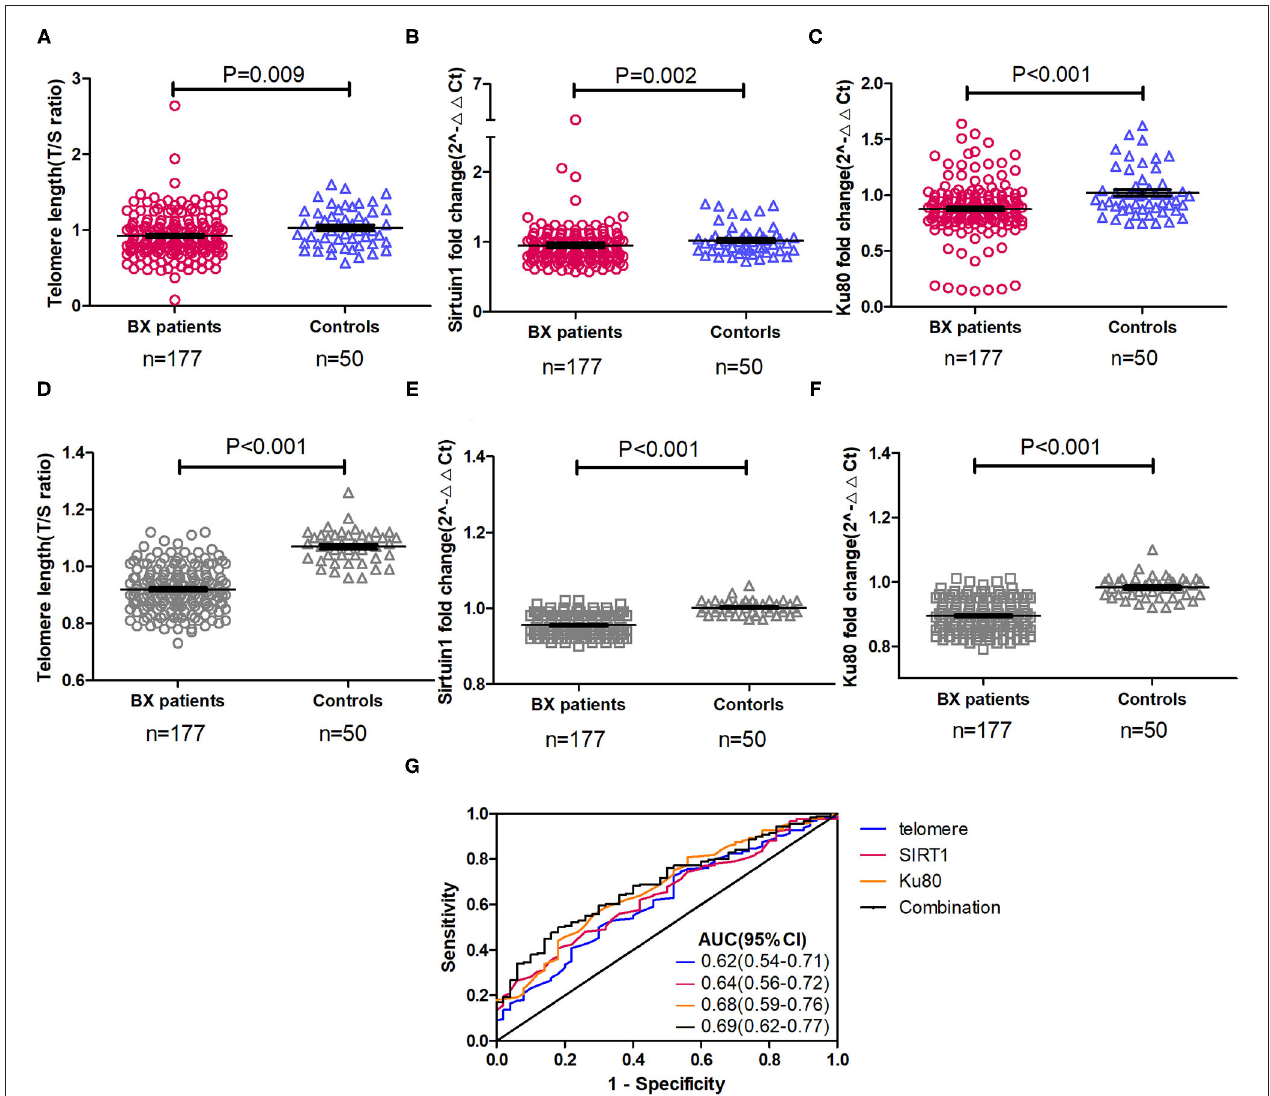
FIGURE 2 | Expression and diagnostic performance of three differentially expressed aging markers in peripheral blood mononuclear cells of patients with clinically stable bronchiectasis and healthy controls. (A–F) The expression levels of different aging markers in peripheral blood mononuclear cells of patients with clinically stable bronchiectasis and healthy controls. (A) The relative telomere length, expressed as the T/S ratio; (B) Sirtuin 1 (SIRT1) expression levels; (C) Ku80 expression levels; (D) Relative telomere length adjusted with the lung age; (E) SIRT1 expression levels adjusted with the lung age; and (F) Ku80 expression levels adjusted with the lung age. (G) The diagnostic performance of aging markers and their combination to discriminate patients with bronchiectasis from healthy controls. Shown are the three differentially expressed markers between patients with bronchiectasis and healthy controls. The expression level of markers was expressed as the fold change by using the 2 − 11 t cycle threshold algorithm, with exception of the T/S ratio for the relative telomere length. Combination denoted the receiver operating characteristic curve of the sum of the three markers (relative telomere length, SIRT1, and Ku80). A total of 45 patients with bronchiectasis had more than one clinically stable visit, whose data were pooled in the clinically stable visit dataset ( n = 177). AUC, area under the curve; Bx,